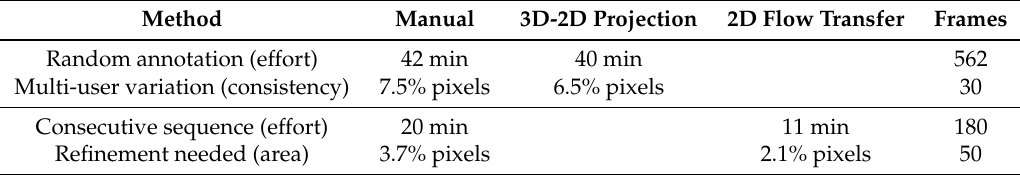
Table 1. Comparison of manual annotation and annotation initialized using the proposed pipeline. The effort is given as mean annotation time per frame, based on the number of sample frames given in the last